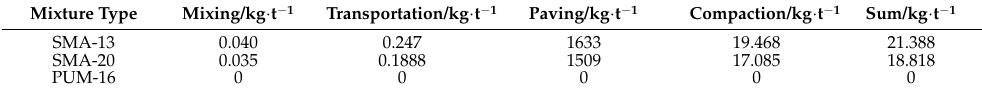
Table 9. High-temperature volatile carbon emissions from hot-mix asphalt mixture kg · t − 1